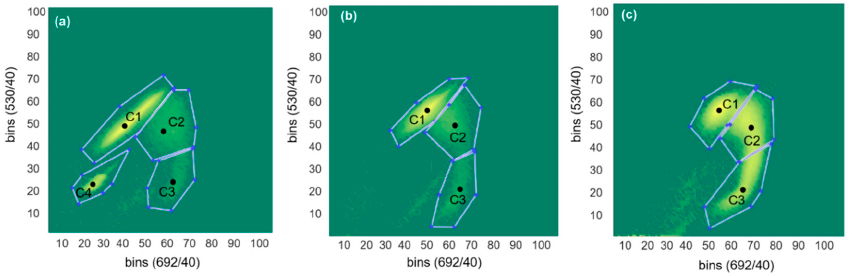
Figure 7. Plot of FL 1 against FL 2 fluorescence intensities showing four clusters (C1-live, C2-intermediate, C3-dead and C4-beads) identified using MATLAB scripts for ( a ) 10th hour sample from pH-A, ( b ) 10th hour sample from pH-B and ( c ) 7th hour sample from pH-C.